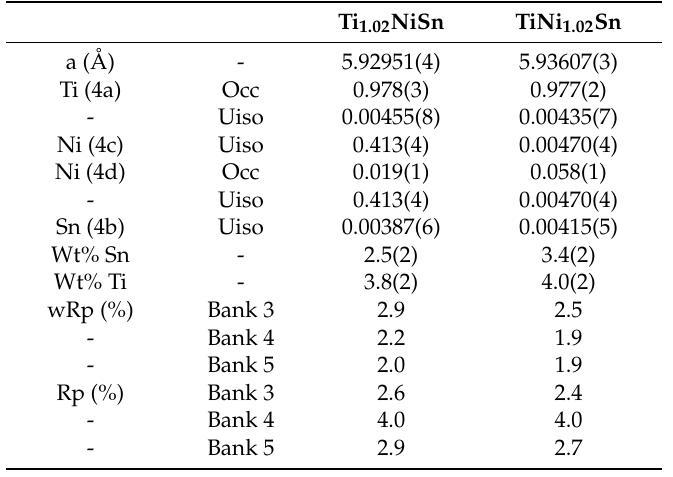
Table 2. Lattice parameters (a), site occupancies (occ), thermal displacement parameters (U iso /Å 2 ), weight percentages Sn and Ti, and fit statistics for the Rietveld fits to Polaris neutron powder